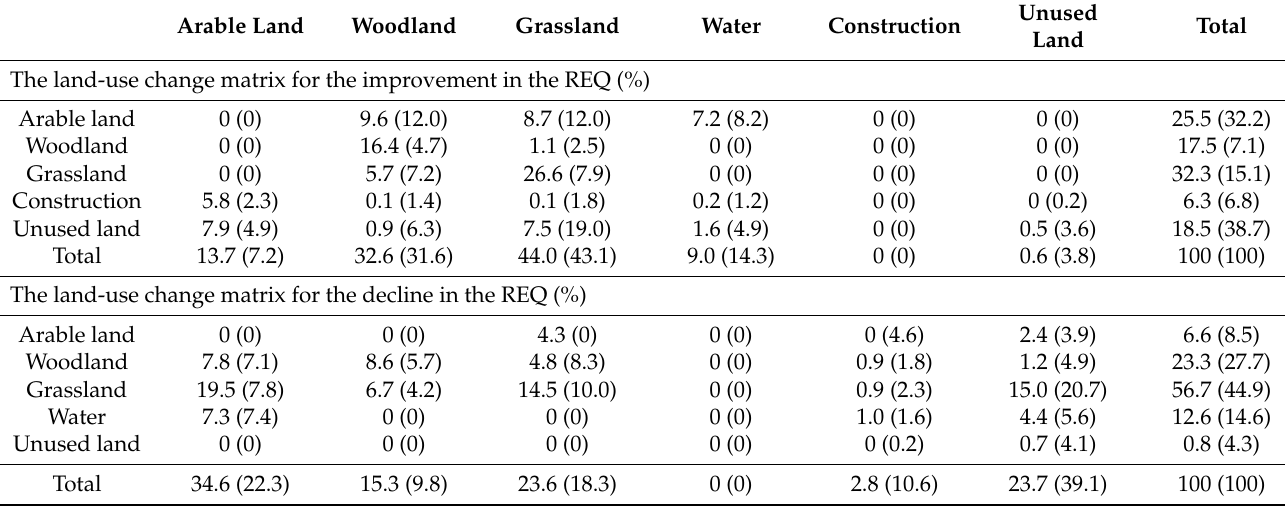
Table 3. The land-use change matrix for the change in the REQ. Arable Land